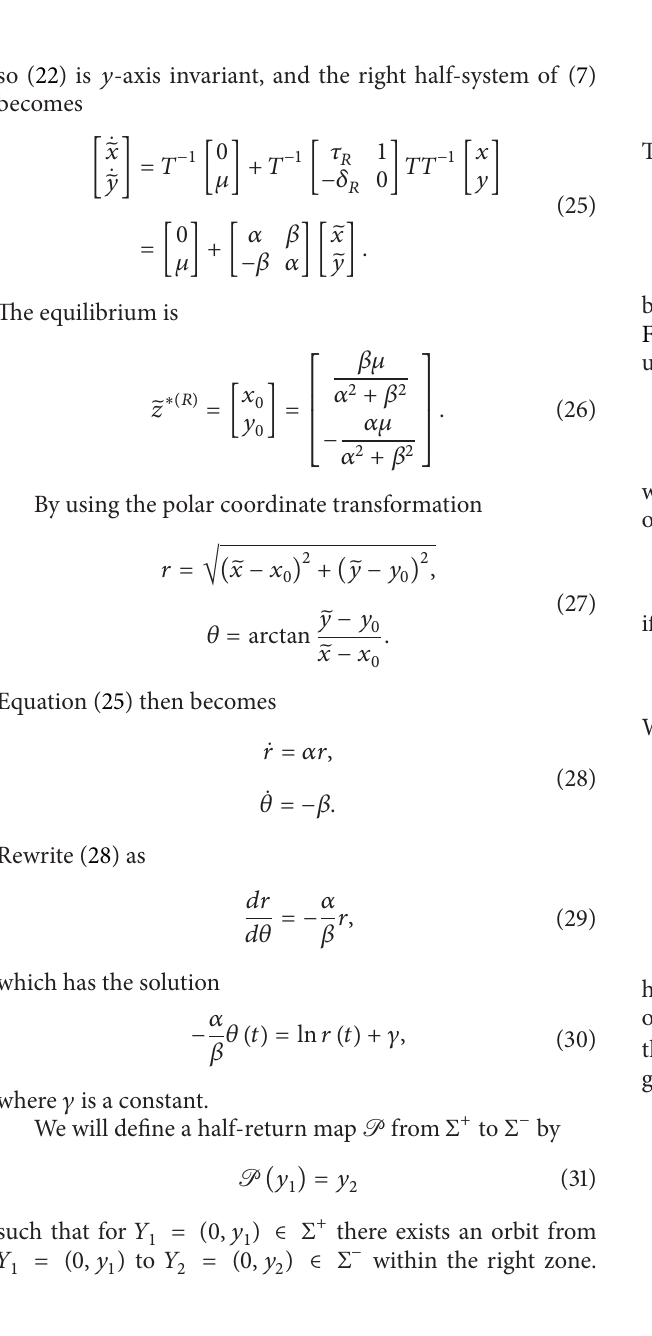
Figure 5: The right zone in the polar coordinate